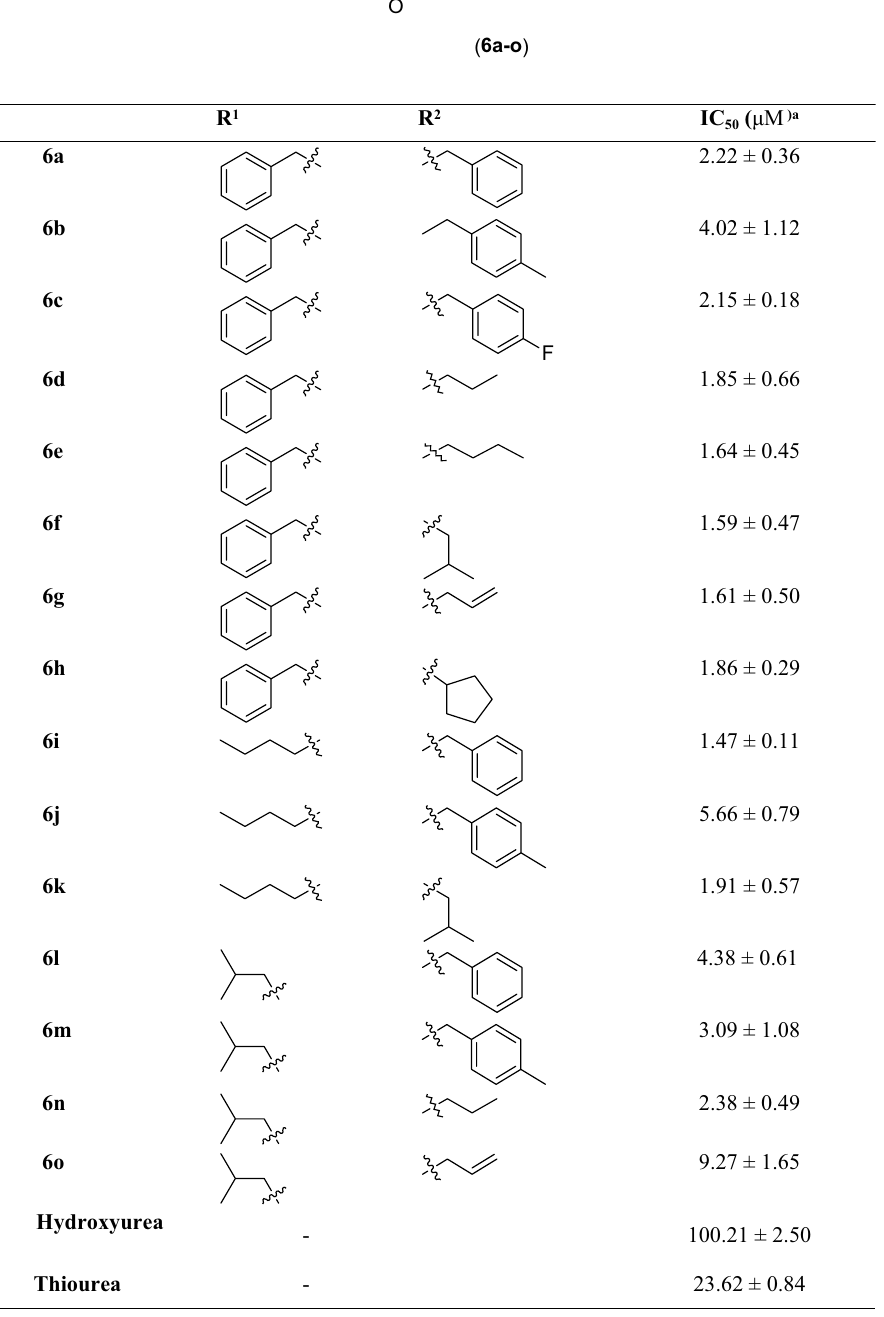
Table 1. Urease inhibitory activity of compounds 6a-n. a Values are the mean ± SEM. All experiments were performed at least three